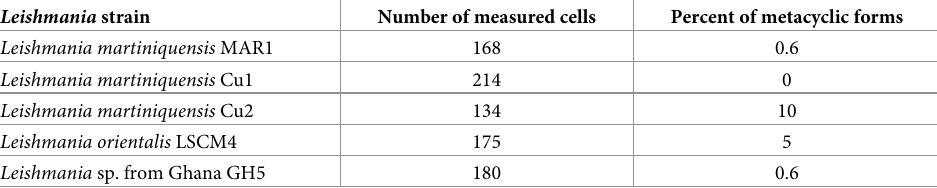
Table 2. Proportion of metacyclic forms developing in C . sonorensis guts 10 days PBM. Leishmania strain Number of measured cells Percent of metacyclic